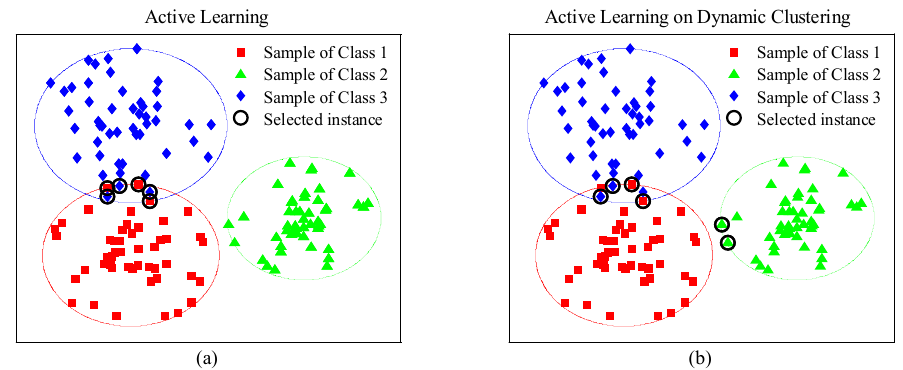
Figure 2. ( a ) E ff ects of traditional active learning; ( b ) e ff ects of proposed Figure 2. ( a ) Effects of traditional active learning; ( b ) effects of proposed AL-DC.